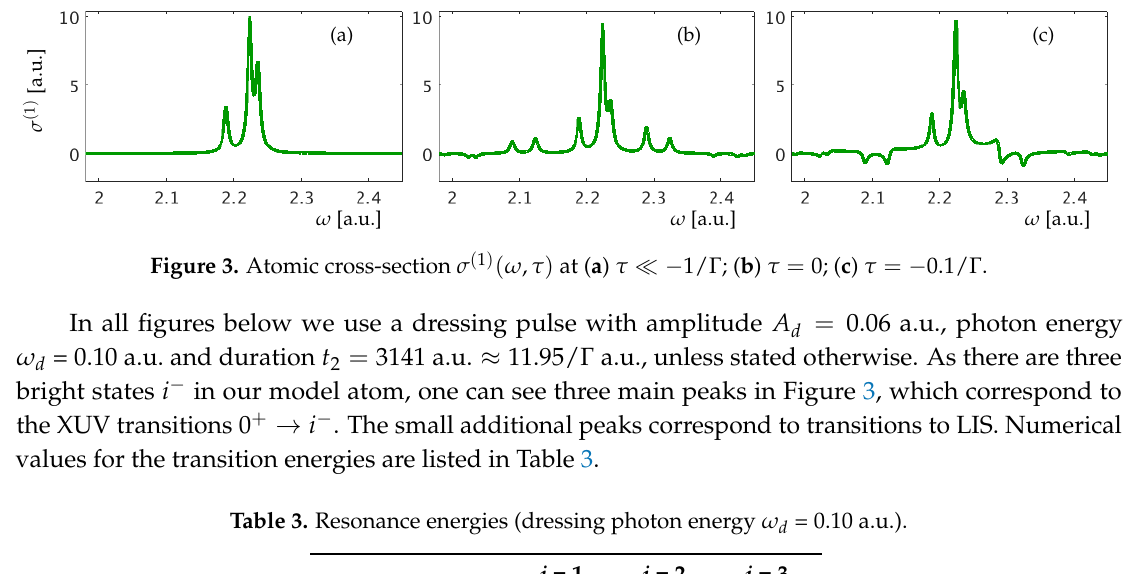
Table 3. Resonance energies (dressing photon energy ω d = 0.10 a.u.).